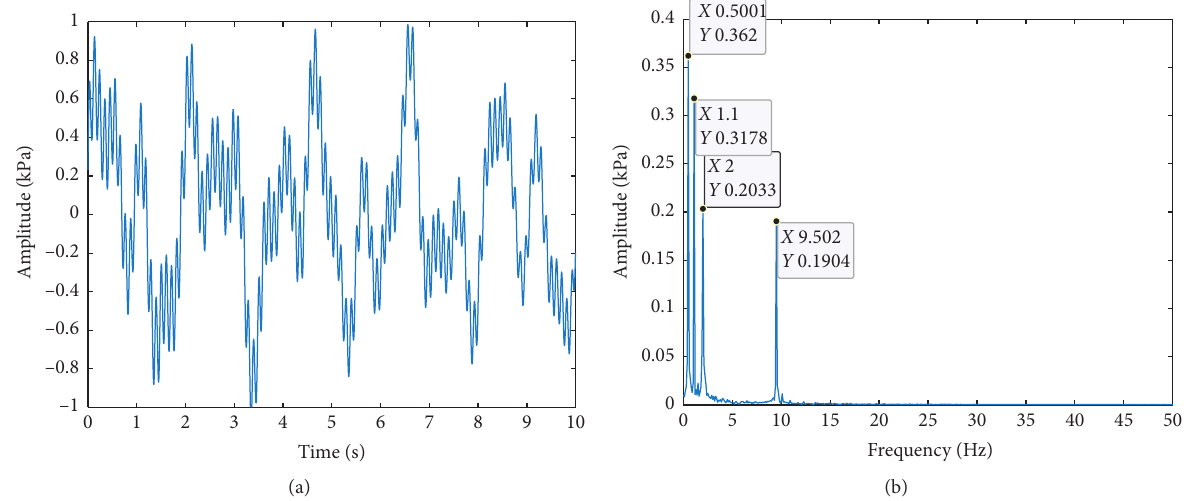
Figure 7: Waveform and spectrum diagram after ALIF-SVD noise reduction. (a) Waveform diagram. (b) Spectrogram.